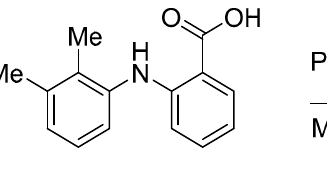
Scheme 1. Synthesis of 1 . Table 1. Physical properties of 1 – 4